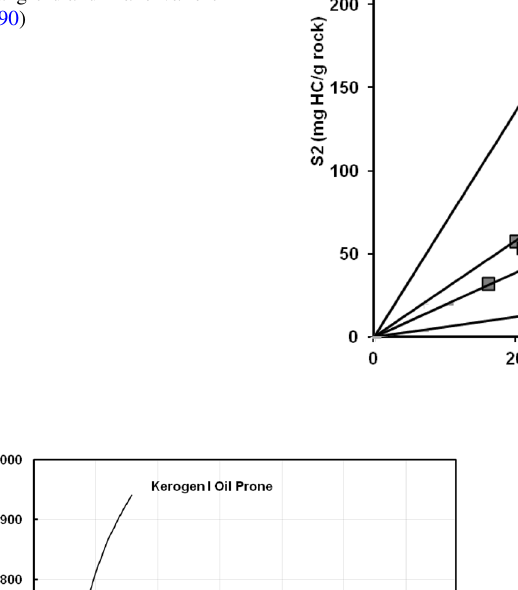
Fig. 5 A cross-plot of S 2 versus total organic carbon (TOC) to identify the type of hydrocarbon produced from both Paleocene and Cretaceous in well Tara-1 (Langford and Blanc-Valleron 1990)